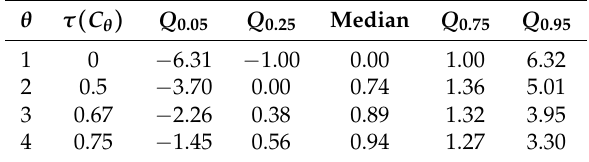
Table 7. Some percentiles of Y = X 1 / X 2 , where ( X 1 , X 2 ) follows Gumbel Copulas. θ τ ( C θ ) Q 0.05